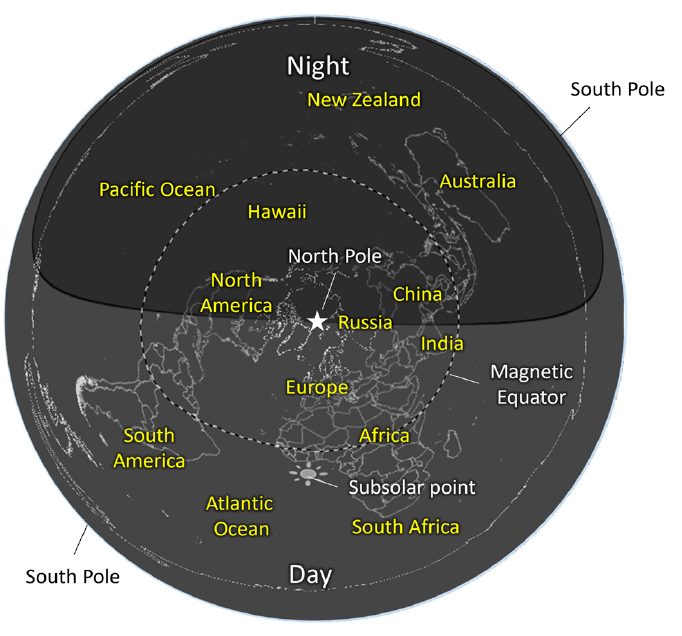
Figure 3. North Polar Gleason projection for the 2D Earth maps. The dashed line is the magnetic equator, and the shaded area corresponds to nighttime.